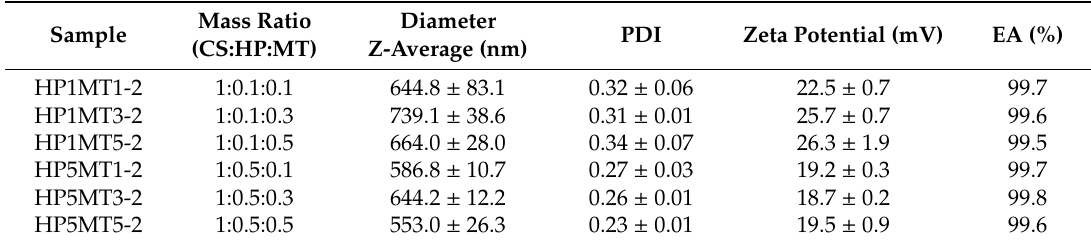
Table 4. Particle size, PDI, and zeta potential of loaded nano PECs prepared by method II (drip) as a function of HP and MT proportions.